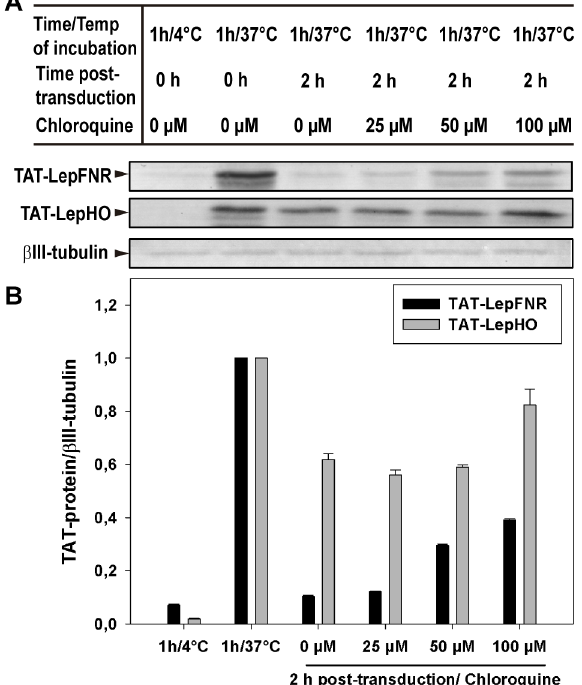
Fig 6. Transduction temperature dependence and chloroquine effectson the stability of the imported protein. (A) SH-SY5Y cells were incubatedwith 3 μ M TAT-LepFNR or TAT-LepHO at 4˚C and 37˚C in a serum free medium. After 1 h of transduction Chloroquine was added to a fresh medium and incubation proceeded up to 2 h. Representative blots of 3 different experiments are shown. (B) Densitometricanalysisof the transduced proteins. Protein levels were normalized to that of β